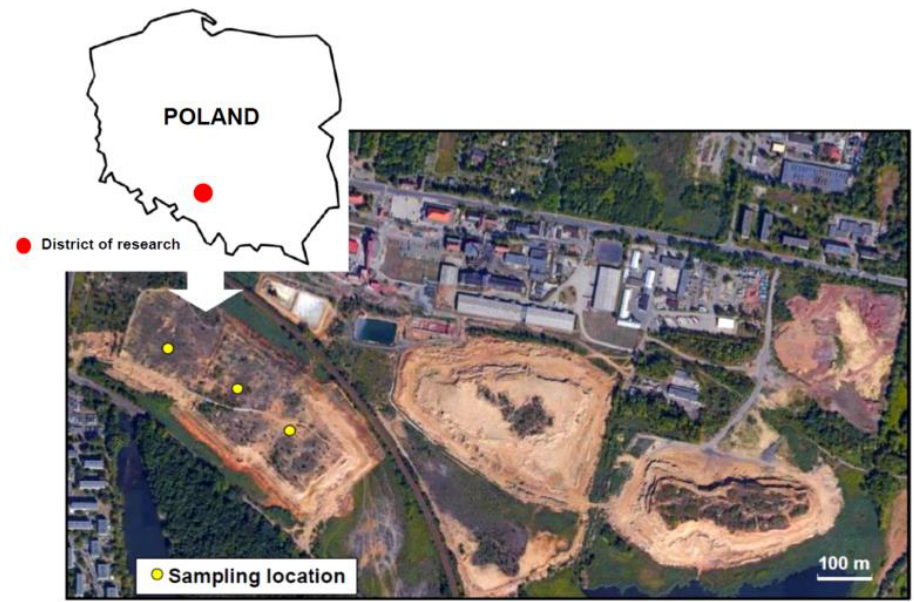
Figure 1. Location of dolomite post-floatation waste sampling site based on www.maps.com.pl (accessed on 26 November 2021).